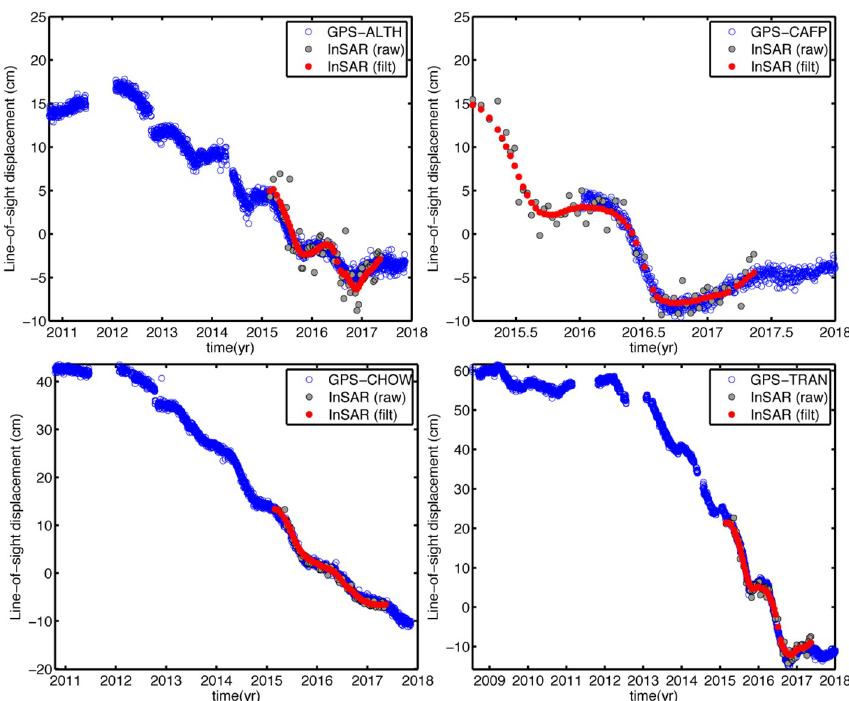
Figure 9. Comparison of InSAR time series and projected GPS LOS time series at selected GPS stations. The GPS LOS displacements are projected using 3‐component position time series. The gray and red circles are the raw and filtered InSAR time series with atmosphere noise removed.